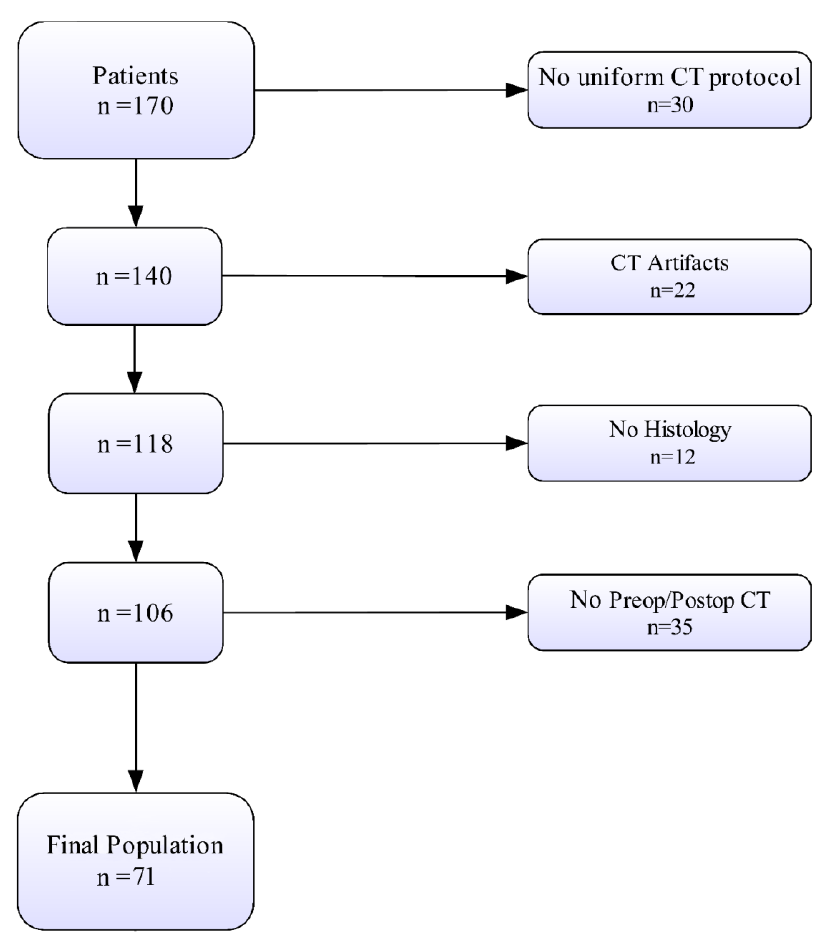
Figure 1. Patient selection. CT, computed tomography